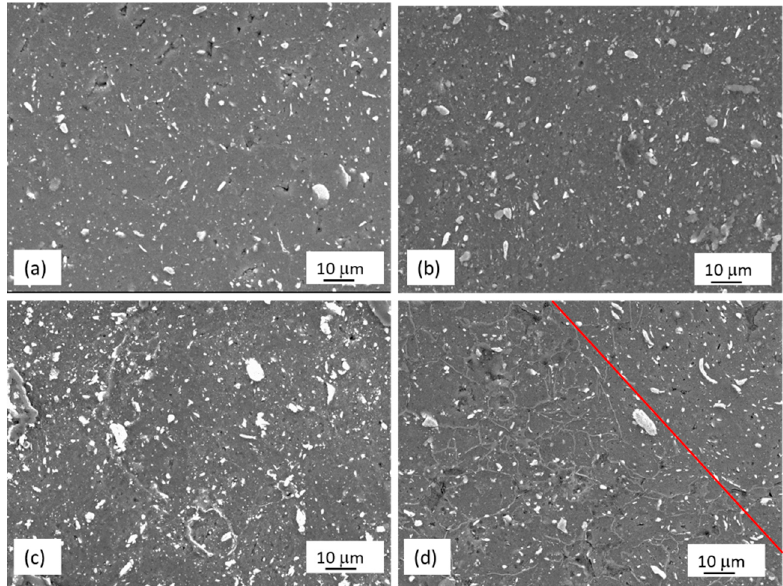
Figure 6. SEM micrograph of powder after compacting by ECAP route C for ( a ) two passes and ( b ) four passes; ( c ) outer zone of powder compacted by ECAP route C and ( d ) interface for interior and outer zone.